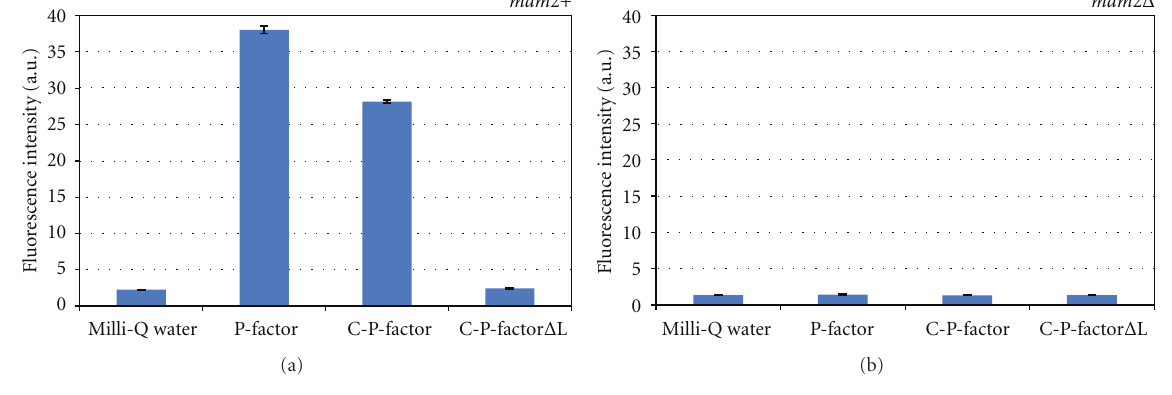
observed in the first force curve measurement were supposed to be caused by the specific interaction between P-factor and its